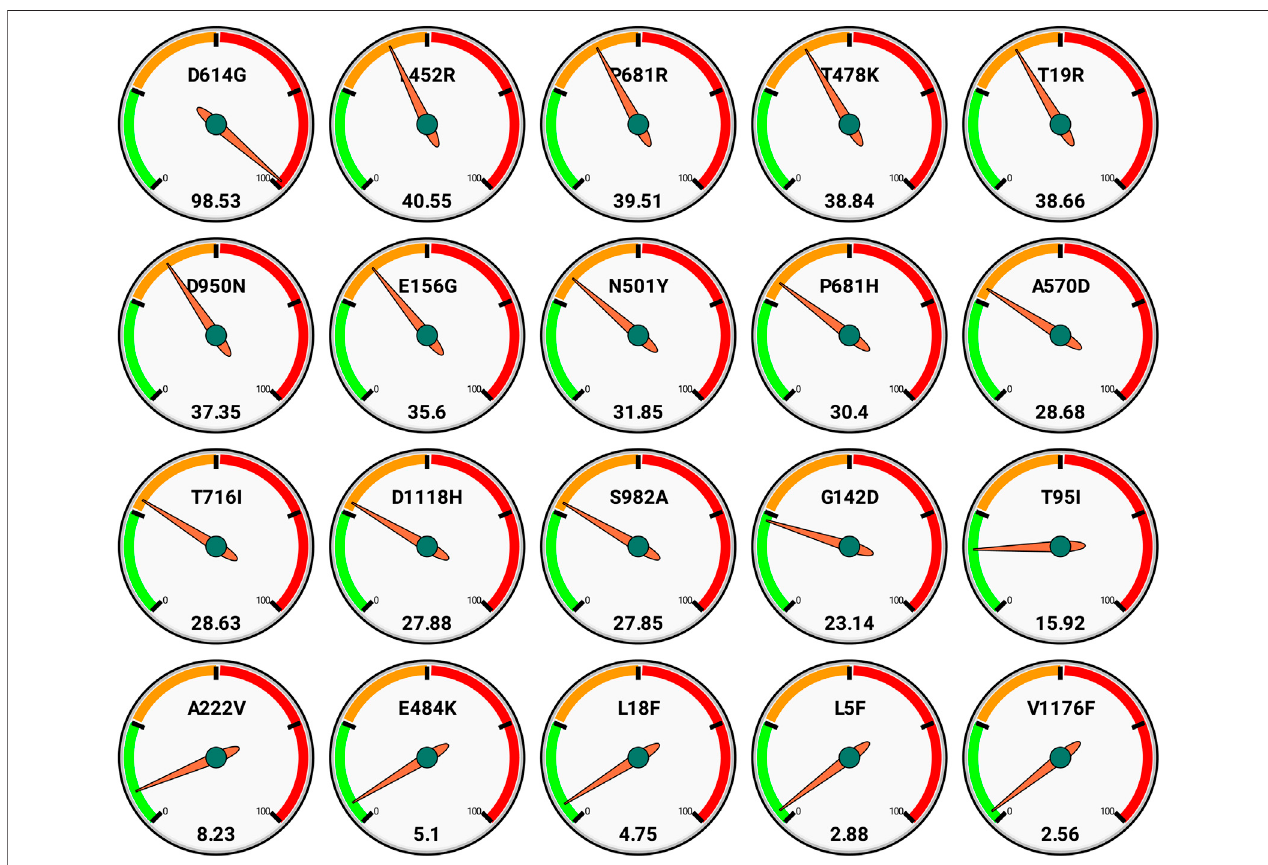
FIGURE3| Globalfrequenciesoftop20nonsynonymousmutationsinthespikeproteinoftheSARS-CoV-2genomes( n (cid:1) 3,897,179)asavailableinGISAIDason dateSeptember30,2021.Eachgaugehasafrequencyscale(0 – 100)dividedquarterlyandrepresentssinglemutation(top)alongwithitsrespectivefrequency(bottom).